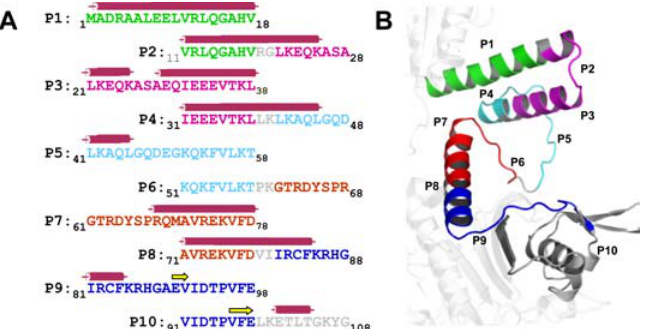
Figure 2. Linear sequence and structural model of murine HRS. Panel (A) depicts the linear sequence of overlapping 18 amino acid peptides comprising the amino terminal 108 amino acids of murine HRS. Color-coding corresponds to the composite three-dimensional model shown in panel